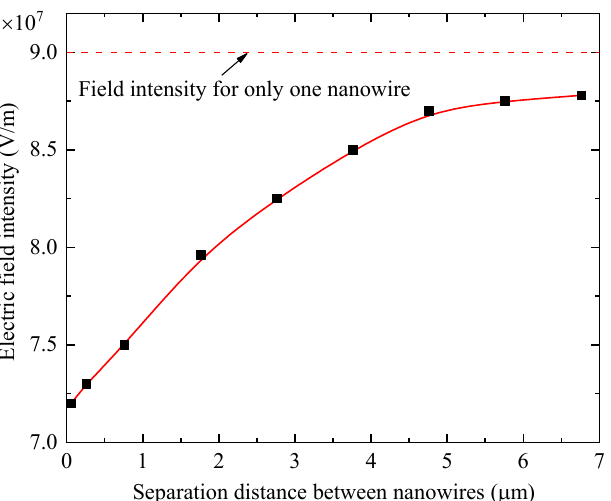
Figure 10. The maximum electric field intensity at the tips of nanowires in dischargers as a function of the separation distance between nanowires.